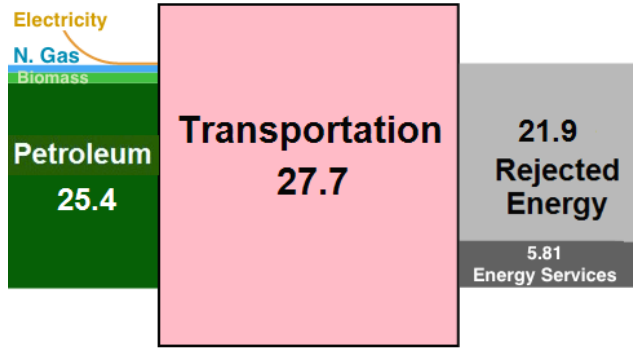
Figure 3. Extract from U.S. Energy Flow Chart shows that 79% of transportation fuel is lost as “Rejected Energy” [16]. Energies 2016 , 9 , 676